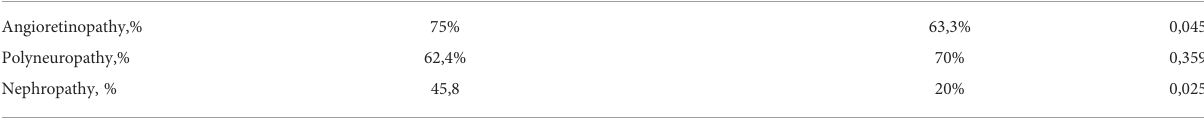
TABLE 2 Characteristics of patient groups according to the presence of microvascular complications of type 1